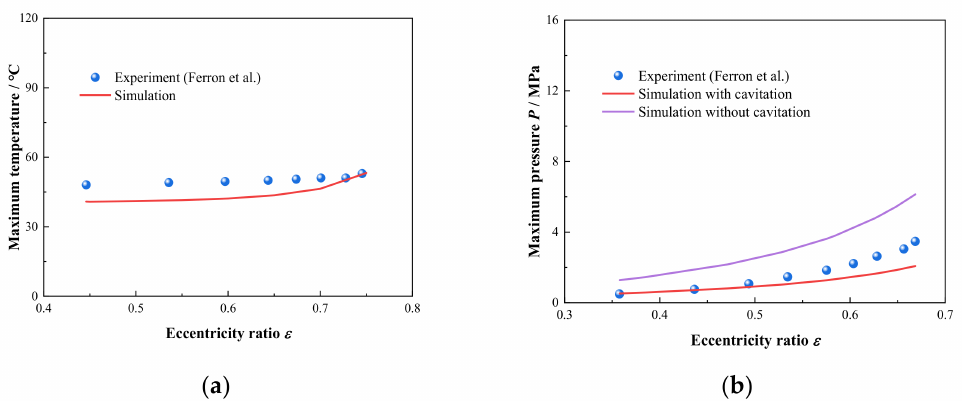
Figure 5. Comparison of simulation results with experiment data in literature ( a ) Maximum tempera- ture; ( b ) Maximum